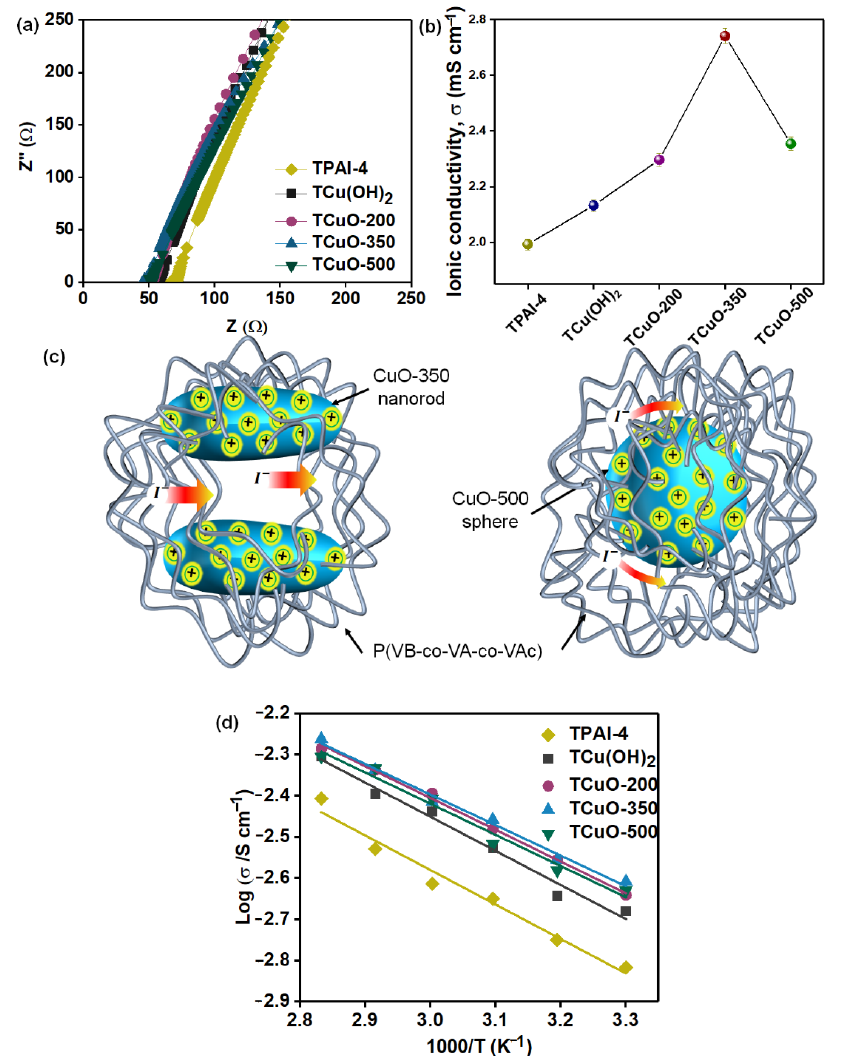
where σ 0 is the constant pre-exponential factor, E a is the activation energy (eV), T is absolute temperature (K), and k is the Boltzmann constant (8.617 × 10 − 5 eV K − 1 ). Among the PCGE samples, it was found that TCuO-350 achieved the lowest E a , which supports its highest ionic conductivity.